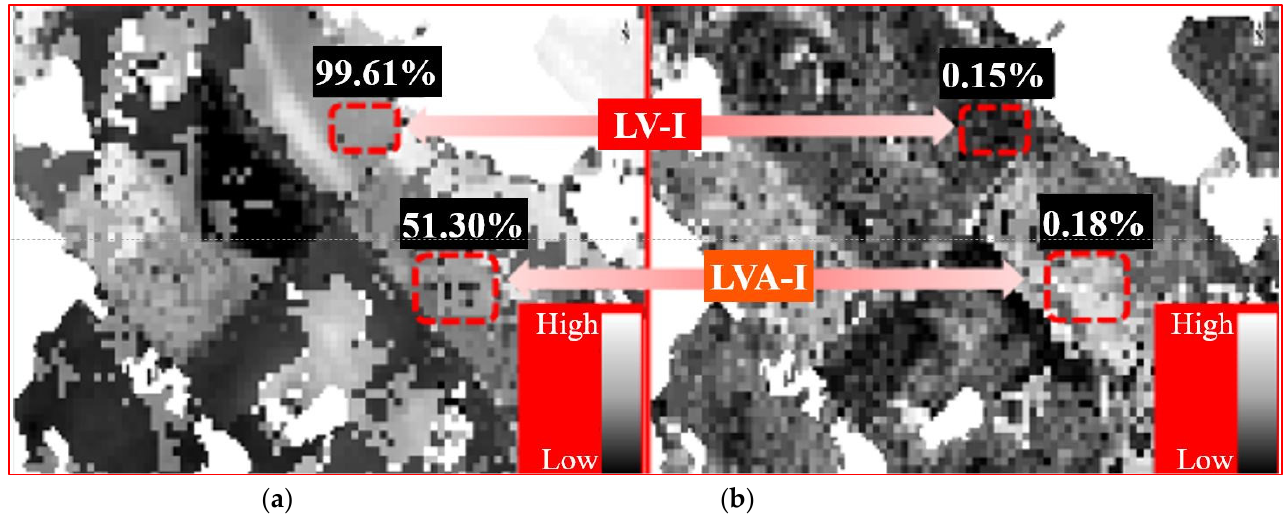
Figure 6. Illustrative values of endmember fraction modeled ( a ) and Root Mean Square Error ( b ) for models LV ‐ I (LATOSSOLO VERMELHO Distrófico típico muito argiloso–Rhodic Ferralsol) and LVA ‐ I: LATOSSOLO VERMELHO ‐ AMARELO Distrófico típico muito argiloso–Haplic Ferralsol). The soil classes’ distribution and arrangement throughout the study area reveal that the DSM (Figure 7) achieved its objective satisfactorily. The hillshade effect supported the soil arrangement observation, highlighting the weathered soils’ predominance in flat re ‐ gions and less evolved soils where the relief was irregular. The soil classes mapped rep ‐ resented 39.7% of the RE (target area), corresponding to about 10.2 ha. This area was con ‐ sidered satisfactory due to the short time series achieved with the methodology adopted for mapping bare soils in this research, agreeing with ref. [13].